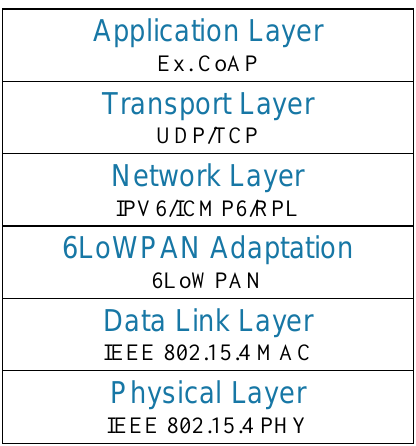
Figure 1. 6LoWPAN protocol